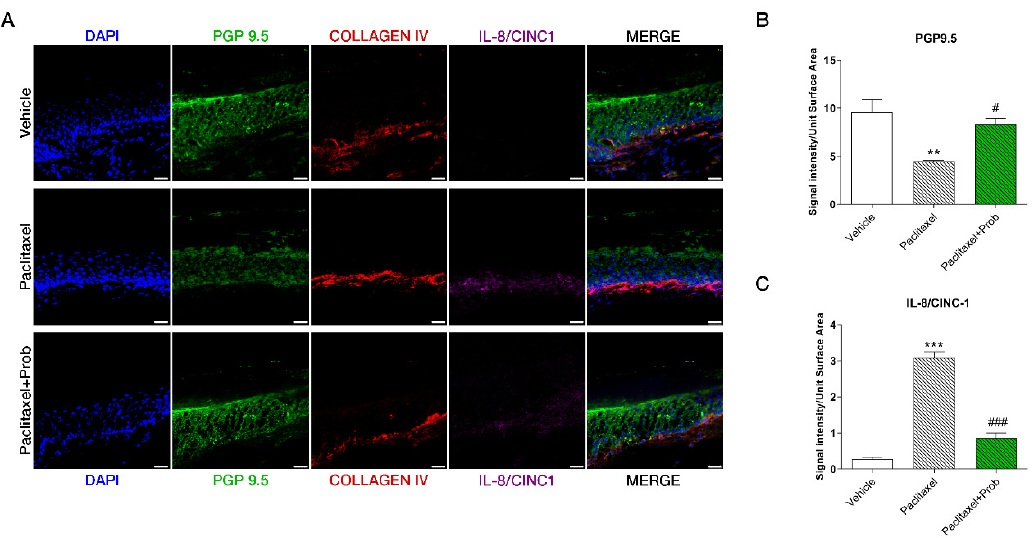
Figure 7. ( A ) Immunofluorescence analyses at confocal microscopy for PGP 9.5 (green), collagen IV (red), IL-8/CINC1 (purple), DAPI (blue) in the paw, scale bar: 25 µm. A representative figure for each marker is shown. Signal intensity analyses for PGP 9.5 ( B ) and IL8 ( C ). **, p < 0.005; ***, p < 0.0001; vs. vehicle; ###, p < 0.0001; #, p < 0.05 vs. paclitaxel ( n = 3).